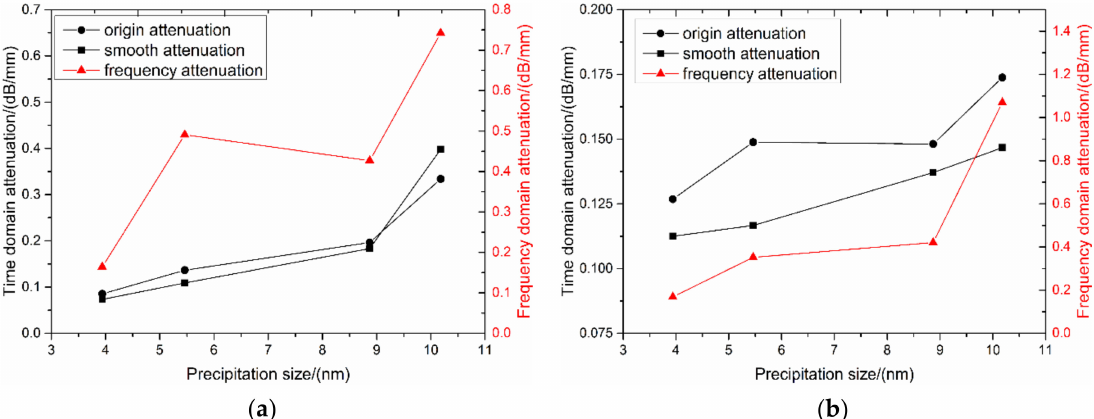
Figure 8. Relationship between the precipitation size and the ultrasonic attenuation coefficient: ( a ) attenuation coefficient calculated by origin signal; ( b ) attenuation coefficient calculated by wavelet signal.